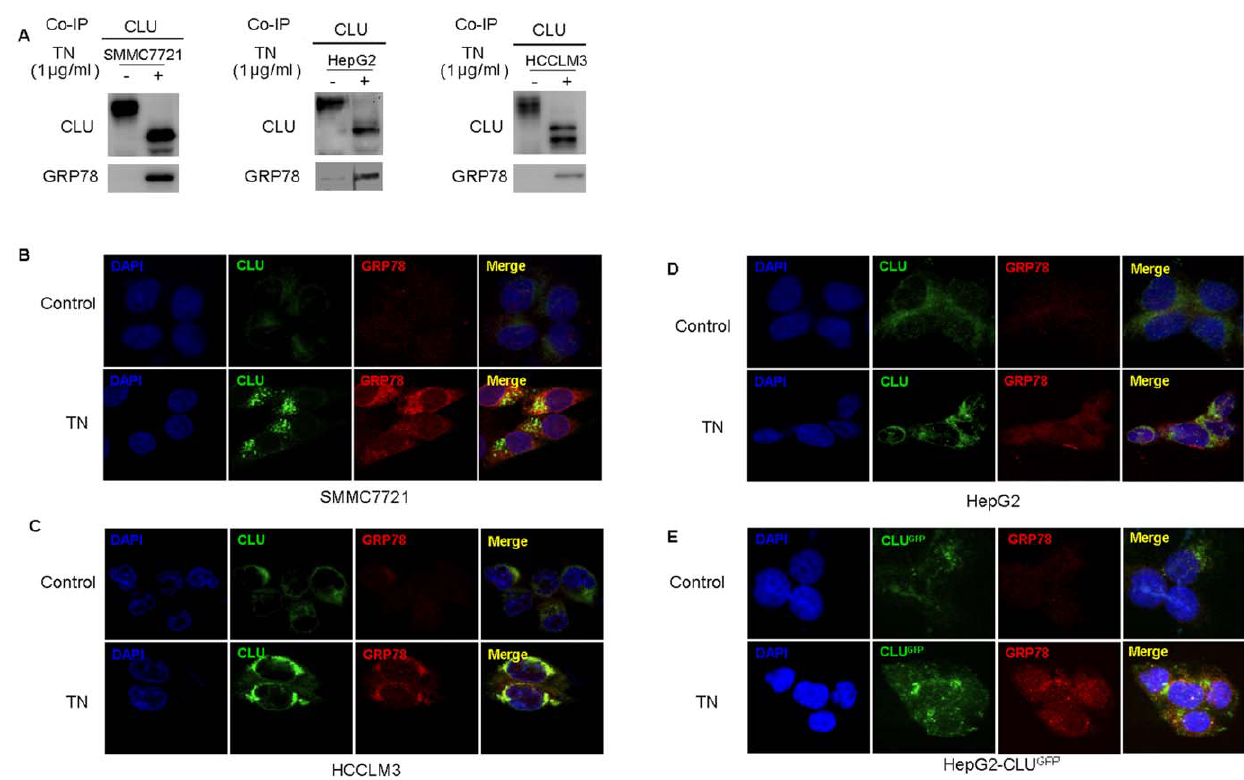
Figure 4. CLU associates with GRP78 under ER stress conditions. (A) Western blot confirmed the presence of GRP78 in CLU co-IP. HCC cell lines (SMMC7721, HCCLM3 and HepG2) were treated with 1 m g/ml TN for 24 h. Pre-cleared protein from whole cell lysates were incubated with goat anti-CLU antibody and then detected with anti-GRP78. (B–D) HCC cell lines (SMMC7721, HCCLM3 and HepG2) were treated with 1 m g/ml TN for 24 h and then co-immunostained with anti-CLU (green) and anti-GRP78 (red). The signals were detected with A1R MP Multiphoton Confocal Microscope. (E) CLU-HepG2 cells were treated with 1 m g/ml of TN for 24 h, the GRP78 was detected by immunostaining with anti-GRP78 (red). Ectopically expressed CLU is tagged with GFP (green). All these data were from a representative experiment and the representative result was from at least three independent experiments.